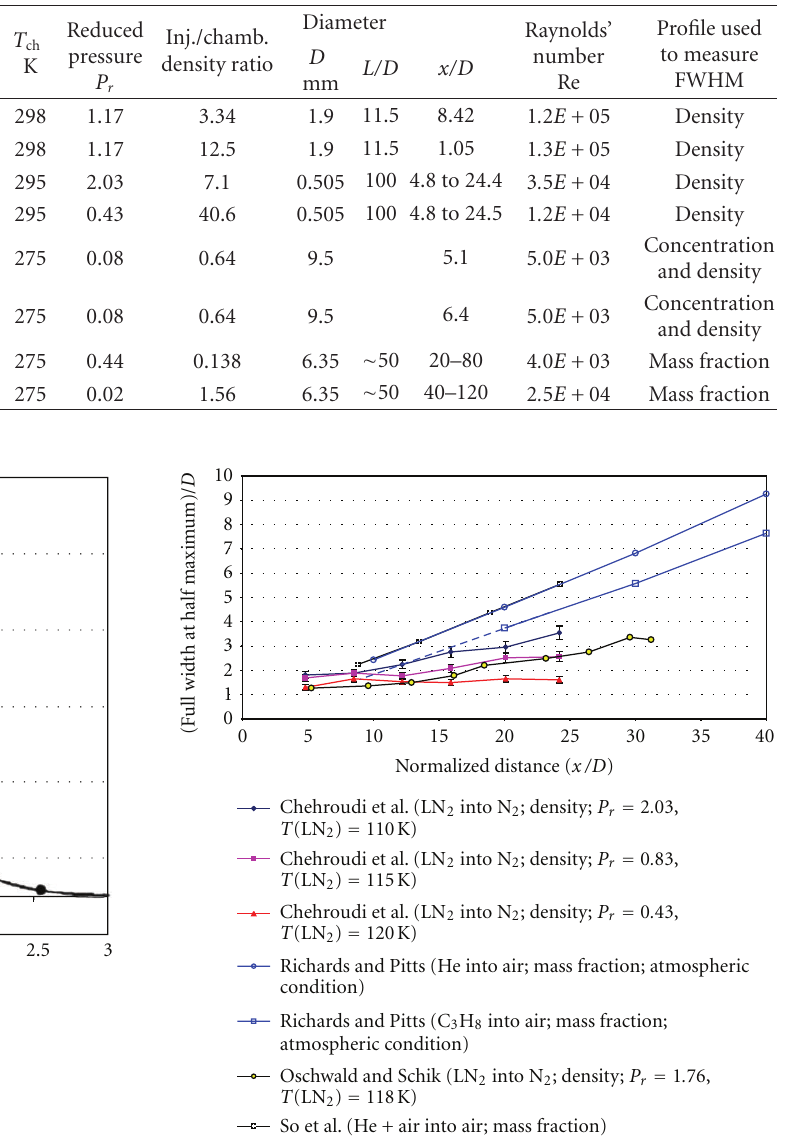
Figure 11: Plots of normalized intensity versus normalized radius for a single LN 2 jet injected into GN 2 , at x/D = 12 . 2, at subcritical, near-critical, and supercritical pressures (Chehroudi et al. [20]). The solid curve is the self-similar model that represents data from a gaseous jet injected into a gaseous environment. I and I ch symbols are measured intensities in the jet and in the chamber far away from the jet, respectively. Chehroudi et al. [20].